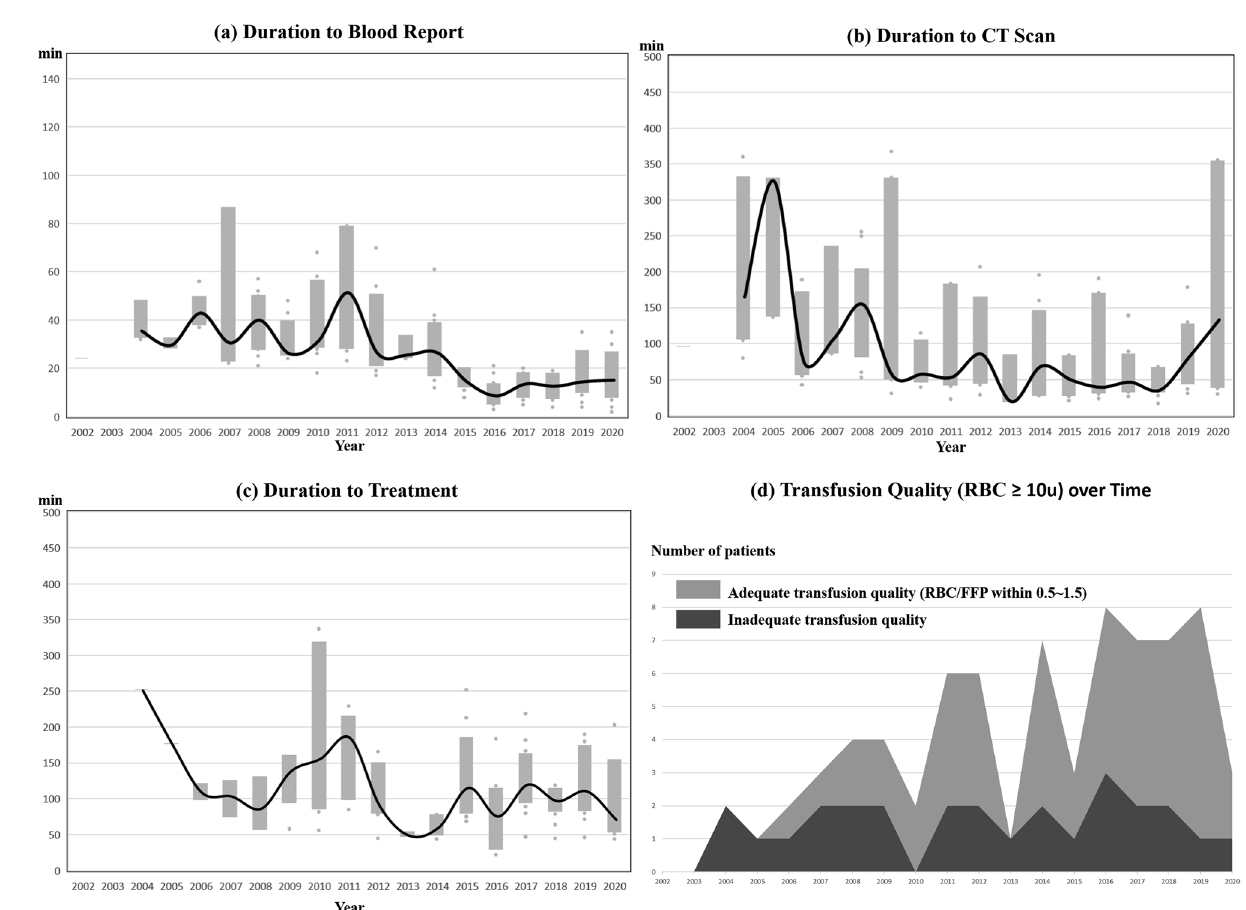
Figure 2. A range of intervals between ED arrival and managements over time. Duration to blood test reports (left upper). Duration to CT scan (right upper). Duration to treatment (left lower). Median curves are depicted. Shaded vertical bars represent interquartile range. Massive transfusion (transfused more than 10 units) quality (percentage of RBC/FFP ratio within 0.5–1.5) over time is shown in right lower